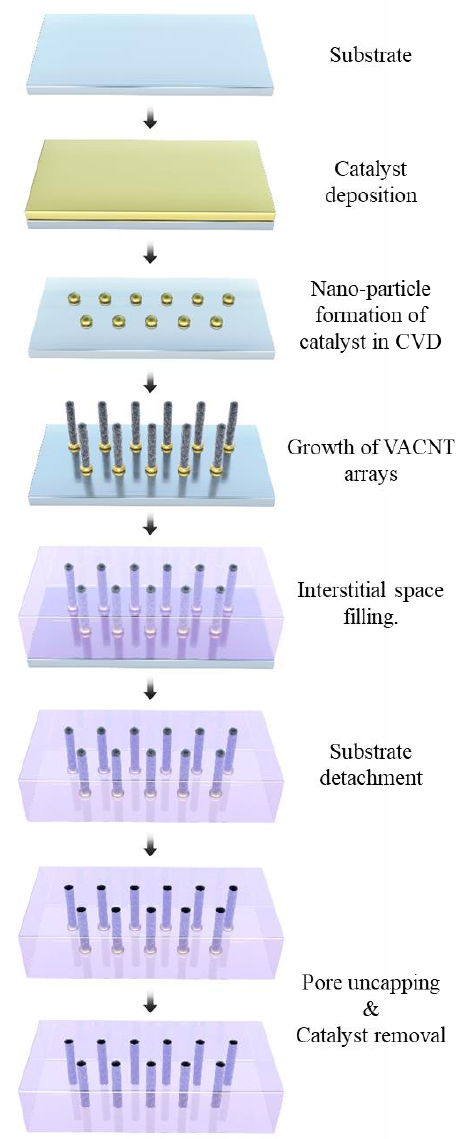
Figure 4. General schematic of vertically aligned carbon nanotube (VACNT) arrays synthesis and the VACNT membrane fabrication process without densification.